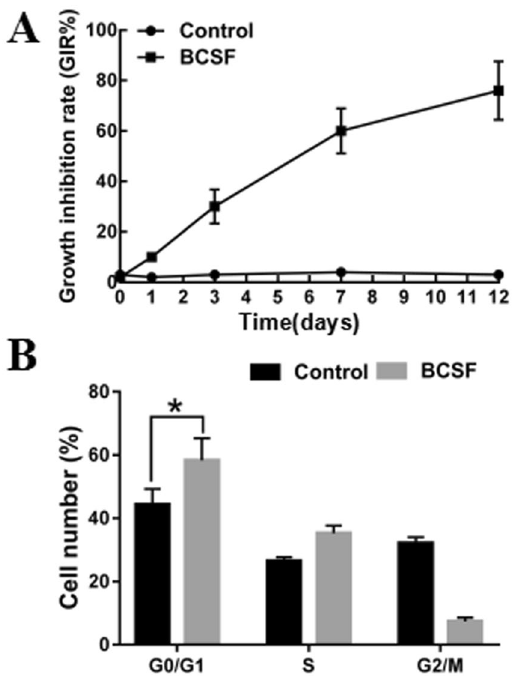
Figure 1. Effects of BCSF on the viability of BMECs. ( A ) MTT assay was performed after BMECs were treated with BCSF for 0d, 1d, 3d, 7d, 12d ( p < 0.05). ( B ) Flow cytometry results showed that BCSF induced G0/G1 phase cell cycle arrest in BMECs (p <